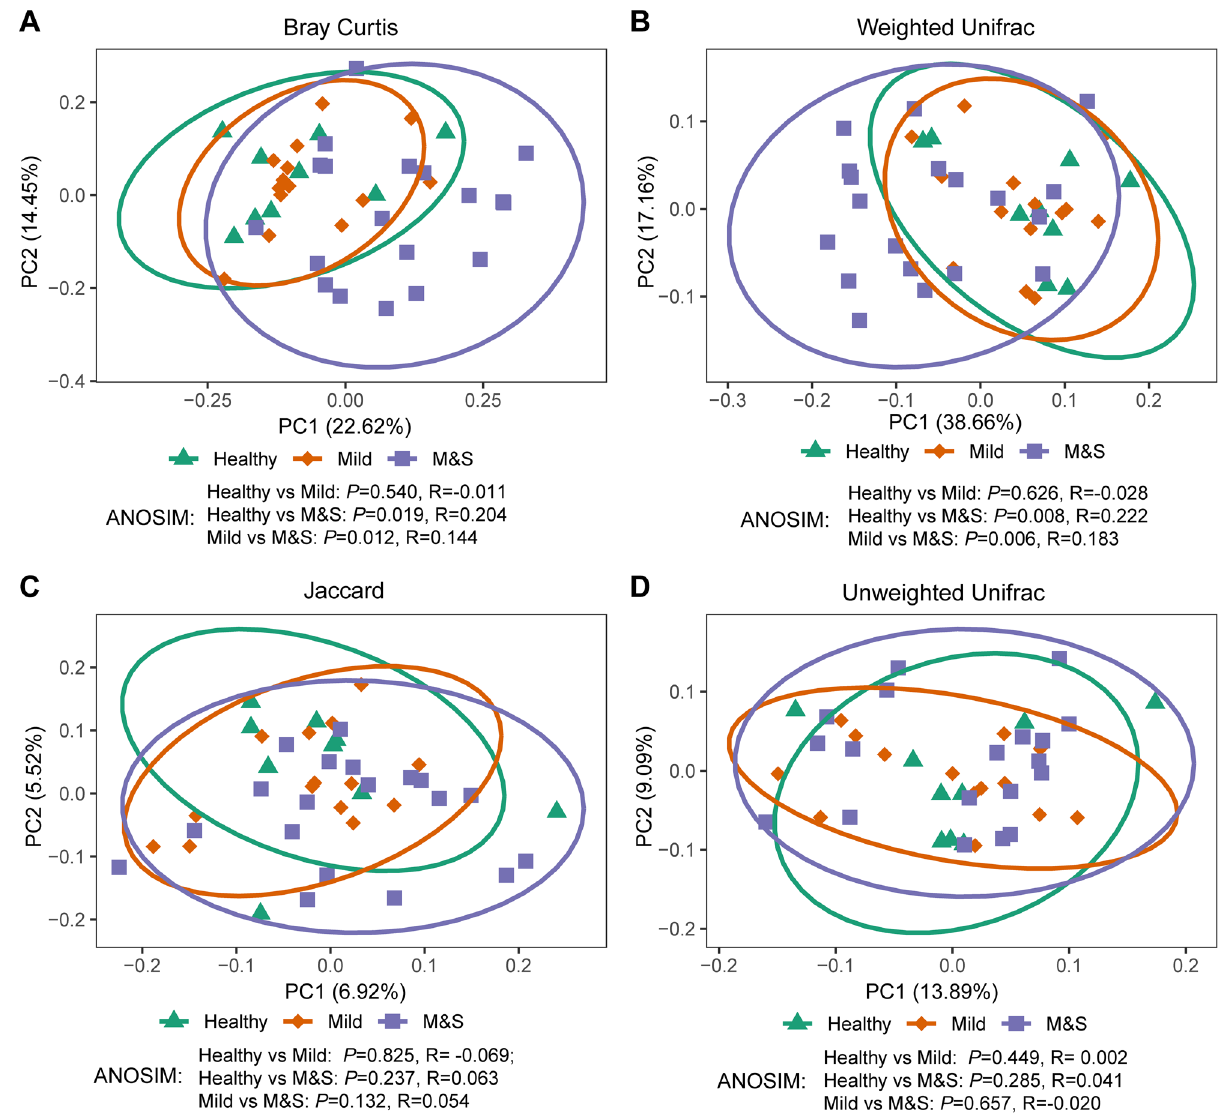
Figure 2. Beta diversity plot of salivary samples based on Principal coordinates analysis (PCoA) of ( A ) Bray–Curtis, ( B ) weighted Unifrac, ( C ) Jaccard, and ( D ) unweighted Unifrac distance. Green/triangle, orange/ rhombus, and purple/square represent Healthy, Mild and Moderate/Severe, respectively. The ellipses were calculated and drawn with 0.95 of confidence level using R/ggplot2 26 moderate/severe dental fluorosis may affect the relative abundance of bacterial species, but not variety. The phyla Firmicutes and Bacteroidetes have critical roles in the human gut. Previous studies suggested that the F/B ratio was an important indicator of the gut microbiota and its relationship with age, body weight, food, metabolism, and disease 30–32 . Similarly, F/B ratio of the oral microbiome was also analyzed in this study. Interestingly, F/B ratio of M&S group was higher than both the Healthy and Mild groups. Based on our results, there was no evidence displaying the F/B ratio relationship between the oral microbiome and oral health status. However, the results indicated that moderate and severe dental fluorosis may cause oral microbial shift. In this study, several important bacterial taxa of the M&S group were significantly different compared to both Healthy and Mild groups, while Healthy and Mild groups shared a similar bacterial community structure. Engström’s study 33 suggested that fluoridated milk did not alter the composition of the salivary bacterial com- munity structure. Indeed, fluoride mouthwash has little impact on the oral microbiome 34 . Study participants, with or without dental fluorosis, did not expose to excessive fluoride for at least 1 year. Therefore, we considered the possibility that fluoride caused the changes in the oral microbiome. The Dean’s Index for dental fluorosis is a widely used classification system that estimates the severity of fluorosis based on clinical appearance of the teeth. In this system, moderate and severe degrees of fluorosis is based on the amount of damage to the enamel surface while very mild and mild is described by the occurrence of white opaque areas. We inferred that surface dete- rioration caused by moderate and severe dental fluorosis made it difficult for patients to clean food and plaque